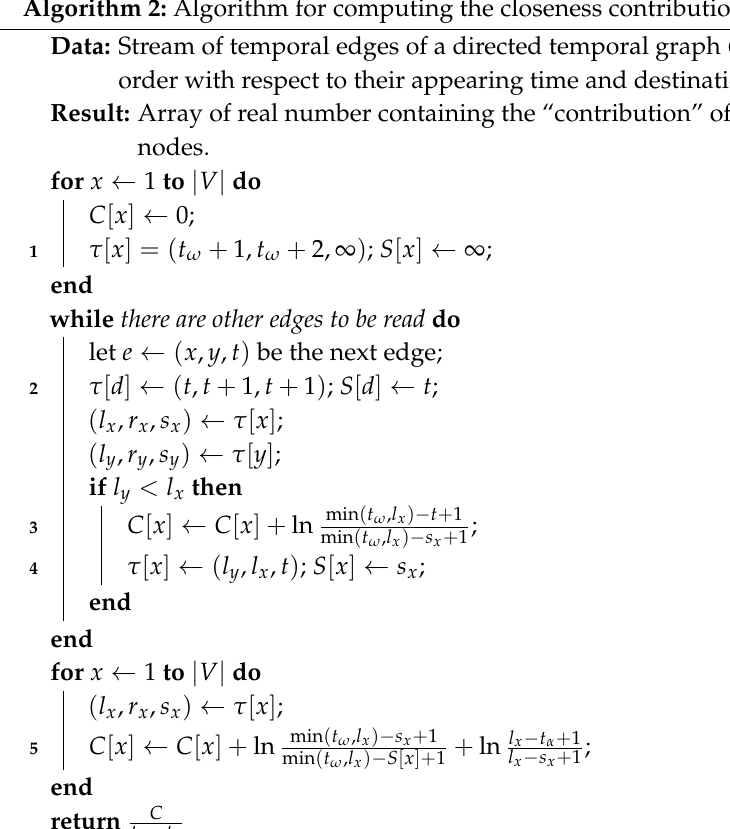
Algorithm 2: Algorithm for computing the closeness contribution of a node to all the others Data: Stream of temporal edges of a directed temporal graph G = ( V , E ) in non-increasing order with respect to their appearing time and destination d